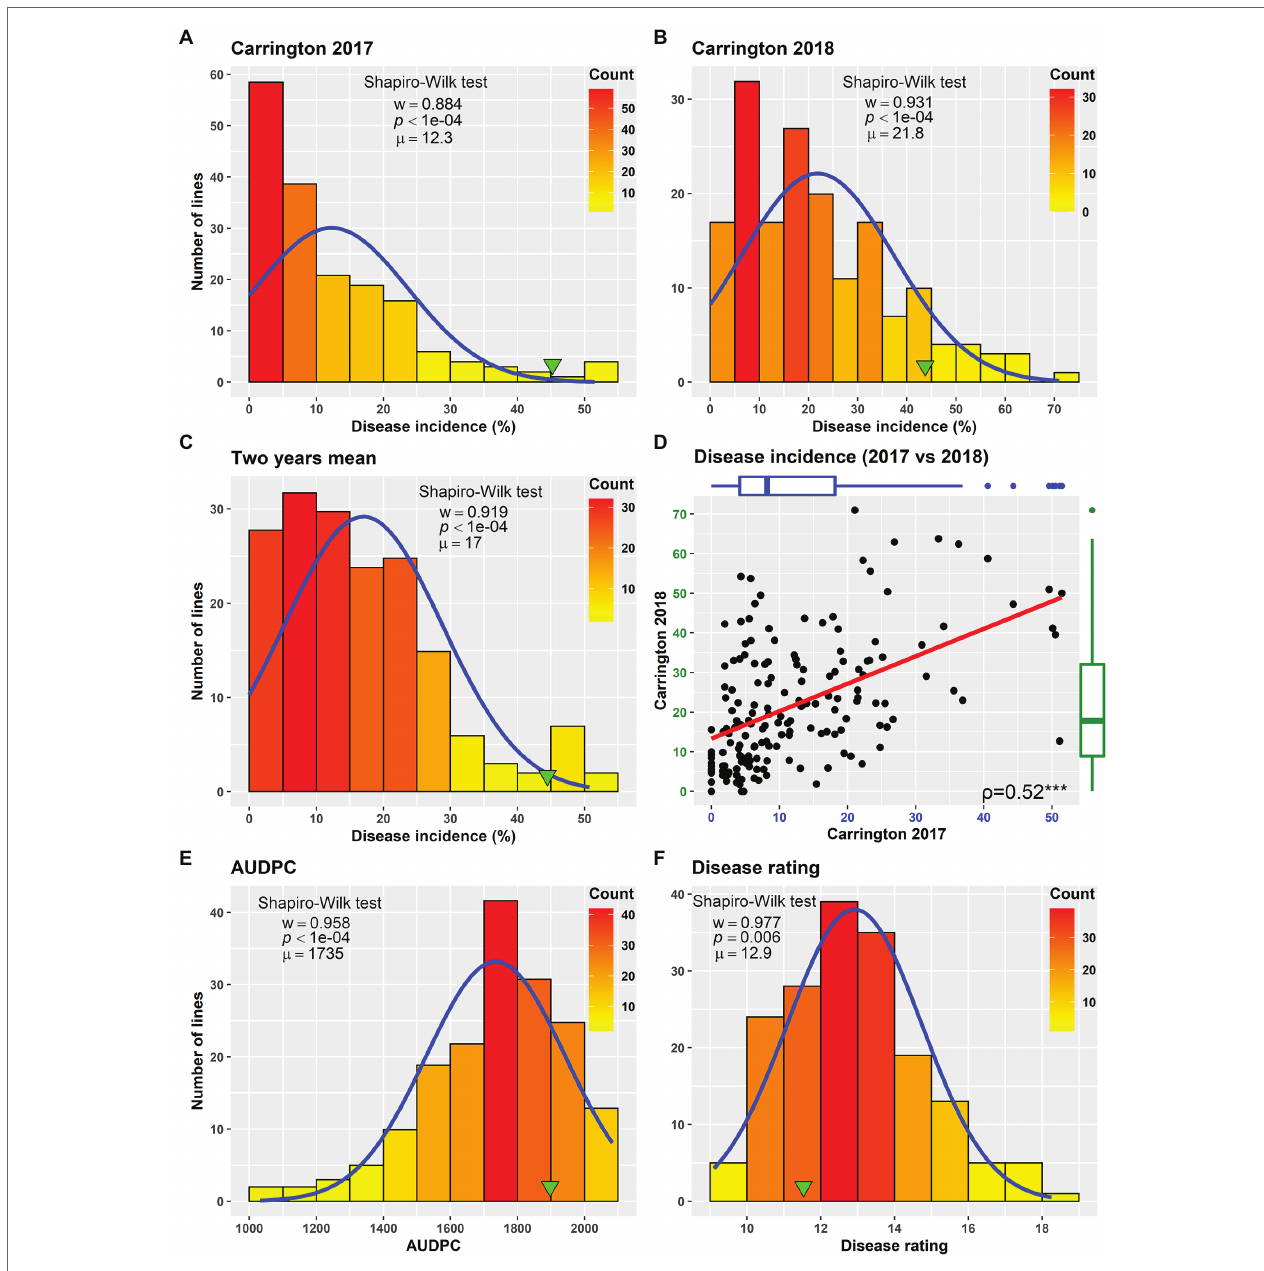
FIGURE 1 | Frequency distribution of Sclerotinia basal stalk rot disease incidence (A–D) , area under disease progress curve (E) and BSR disease rating (F) in the HA 89/ Helianthus praecox AB-QTL population evaluated in the field in Carrington, ND during 2017–2018 (A–D) and in the greenhouse in 2018 (E,F) . The green arrowheads indicate the value of the recurrent parent HA 89. The Shapiro–Wilk normality test statistic ( w ), the probability value ( p ), and the mean ( μ ) of the data for each environment are shown inside the respective